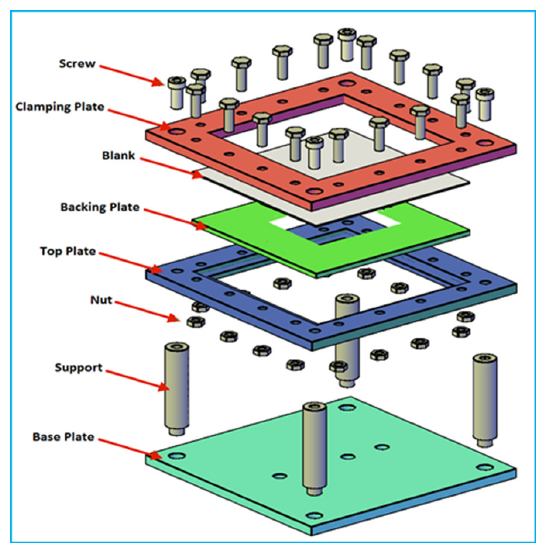
Fig. 4. Assembly view of the forming frame.